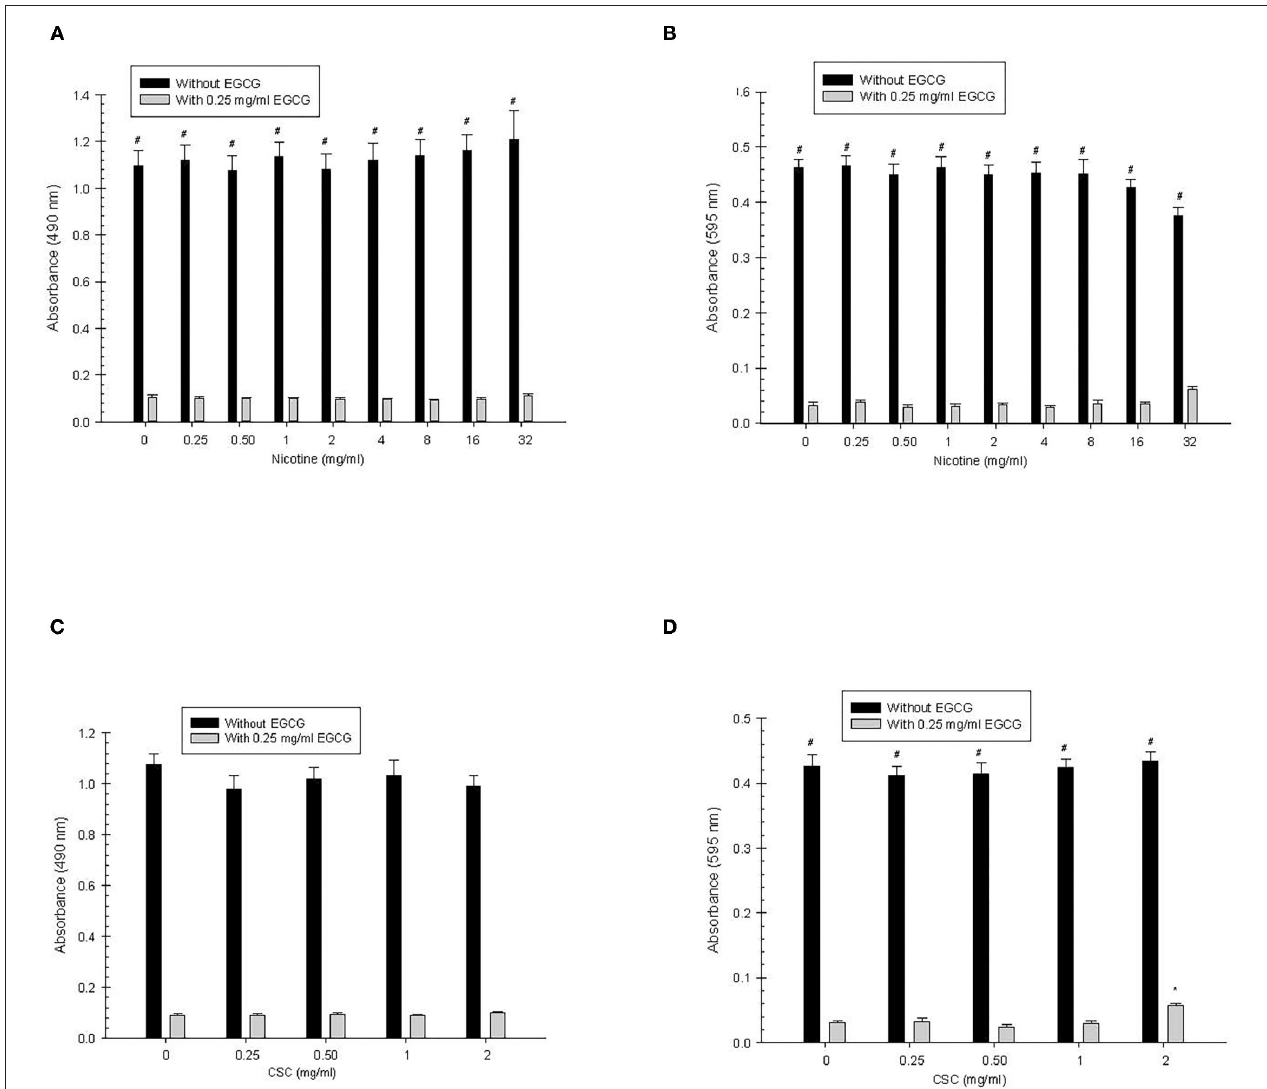
FIGURE 2 | Secondary S. mutans biofilm (A,C) and total absorbance (B,D) nicotine/CSC exposure effects. # Indicates significant differences between growth with 0.25 mg/ml of EGCG and without EGCG. * and @ indicates significant differences between 0 mg/ml nicotine/CSC and other concentrations with 0.25 mg/ml of EGCG and without EGCG,